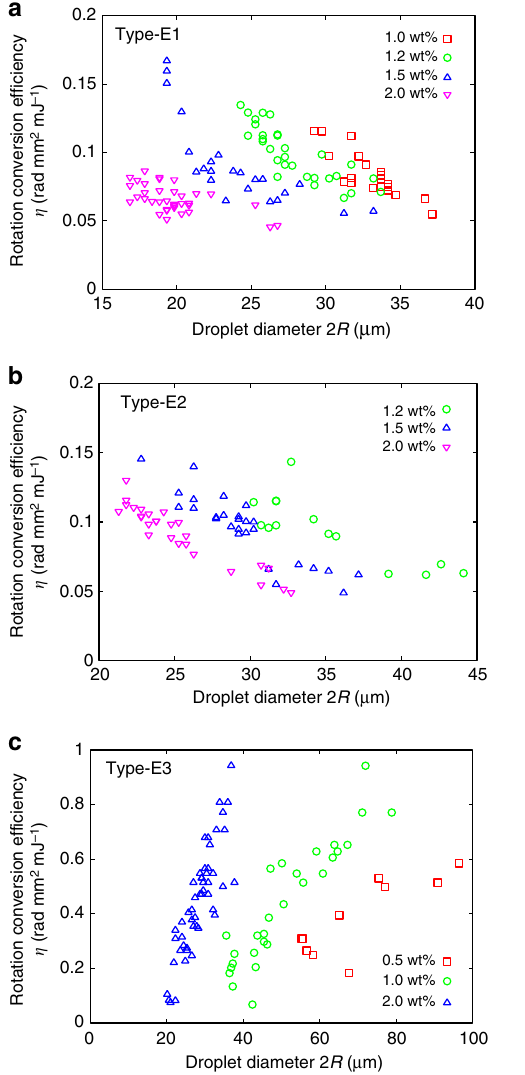
Fig. 7 Rotation conversion ef fi ciency η of Type-E. A clear difference is observed among the samples with different strengths of chirality (see legend). a , b Type-E1 and Type-E2 show η decreasing as either 2 R or the